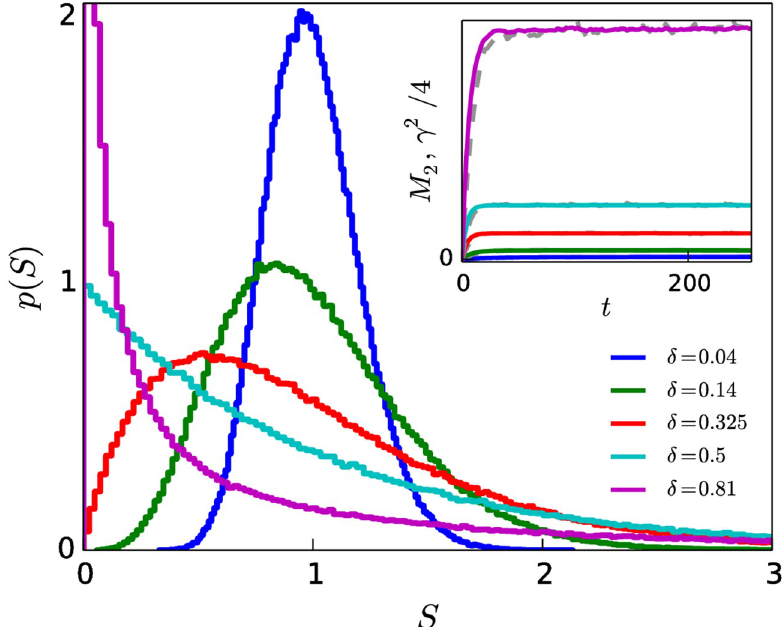
Fig 2. Shape of status distributions as function of δ , with α = 0. Distributions range from more egalitarian (e.g. δ = 0.04: all individuals have close to the average status) to highly unequal (e.g. δ = 0.81: most individuals have very low status and small portion of the population has very high status). Inset of (a): plateau in M 2 (coloured) and squared skewness (grey) indicate that status distributions are in steady-state. Larger values of δ correspond to larger steady- state value of M 2 , such that M 2 provides a measure of the level of inequality of the society. Distributions obtained after simulating up to time t ¼ 64^ t . N = 10 5 , n r = 5. 1